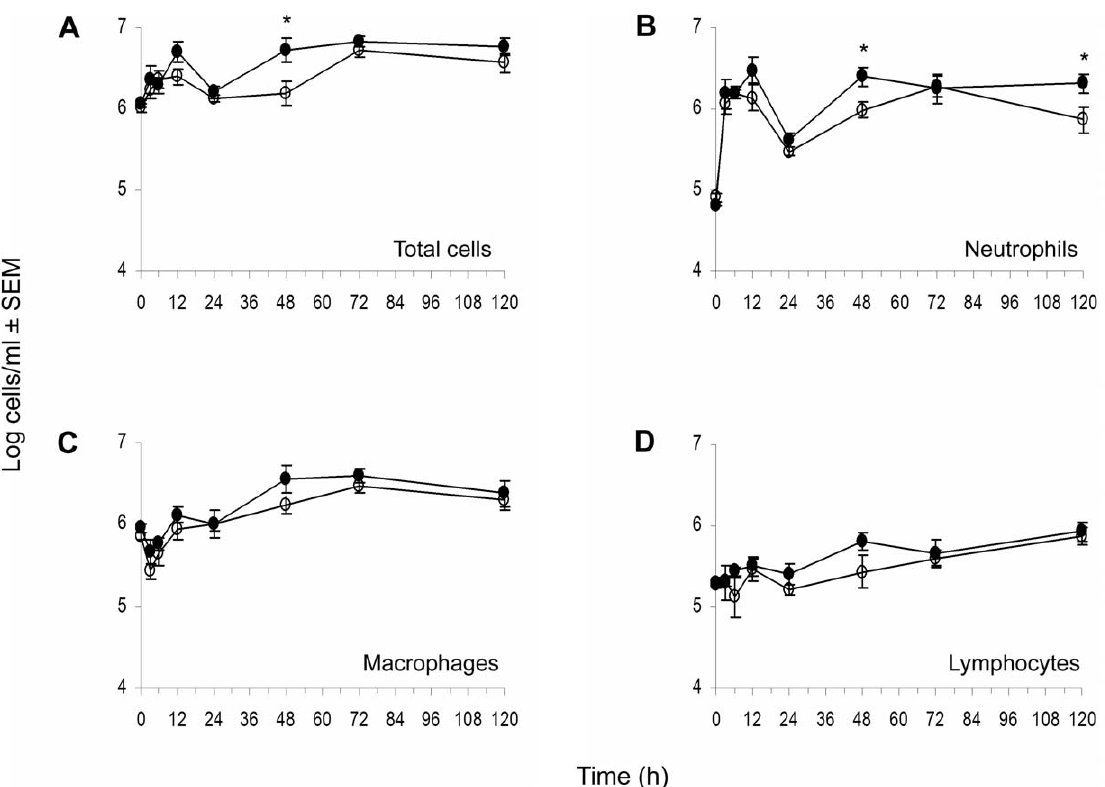
Figure 2. Cellular kinetics of peritoneal fluids recovered from S.aureus infected mice. At different time points, animals were euthanized, and peritoneal lavage fluids were collected. Total cell counts (A) were determined with a hemocytometer. For differential counts cytospin preparations of peritoneal cells were stained with Diff-Quik, and neutrophils (B), macrophages (C), and lymphocytes (D) were enumerated. 7 : nondiabetic mice, , : diabetic mice. * indicates P , 0.05 by the unpaired Student t test. doi:10.1371/journal.pone.0023633.g002 incubated ex vivo for up to 18 h. Since some variability was observed among the experimental animals, we tested age-matched female diabetic and nondiabetic mice in pair-wise comparisons.